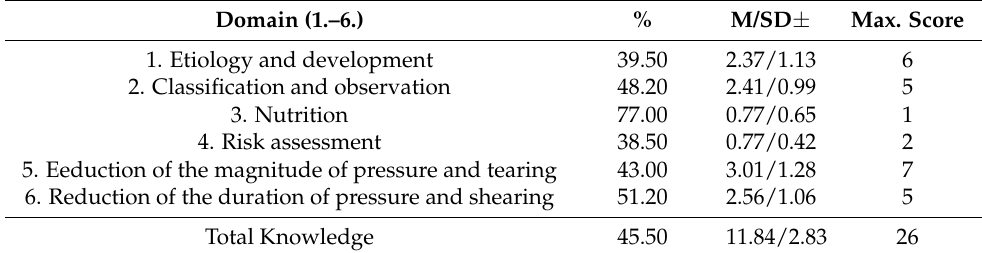
Table 1. Descriptive statistics of Knowledge (domains and total).